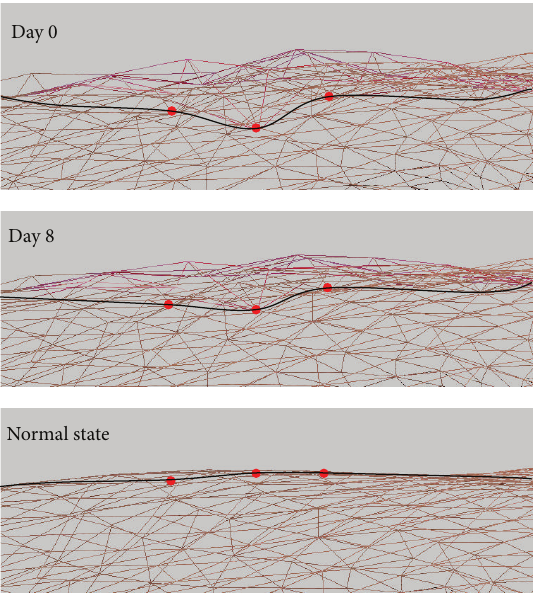
Figure 5: Change in depth as the wound